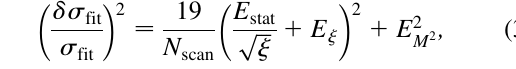
) for the measure- stat (cid:1) ey